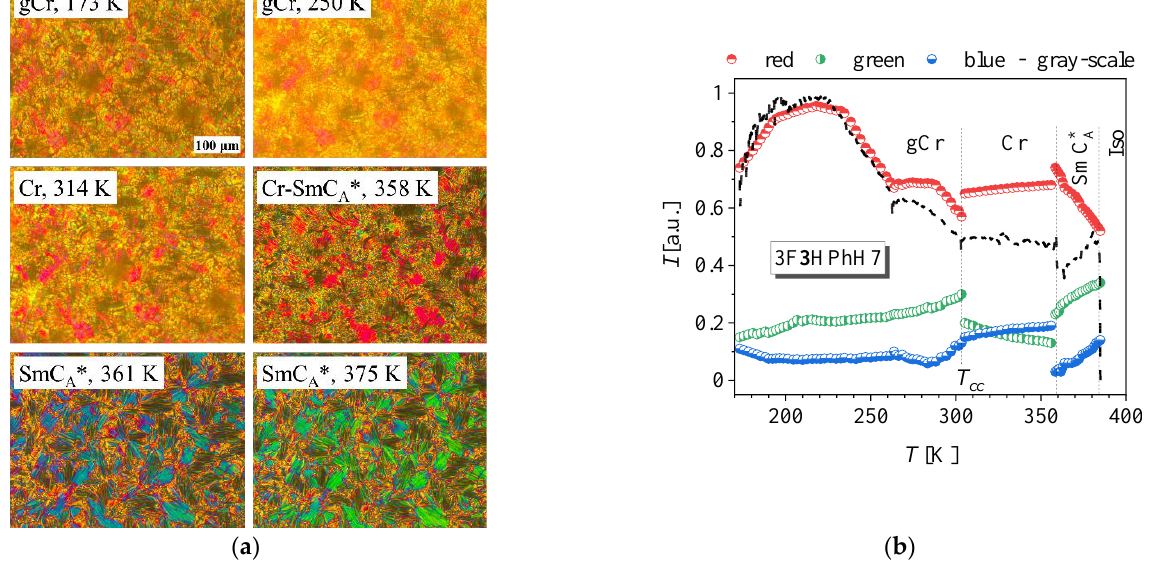
Figure 3. POM textures registered upon heating of the 3F 3 HPhH7 after previous fast cooling ( a ) and the results of the thermooptical analysis of textures collected upon heating ( b ).